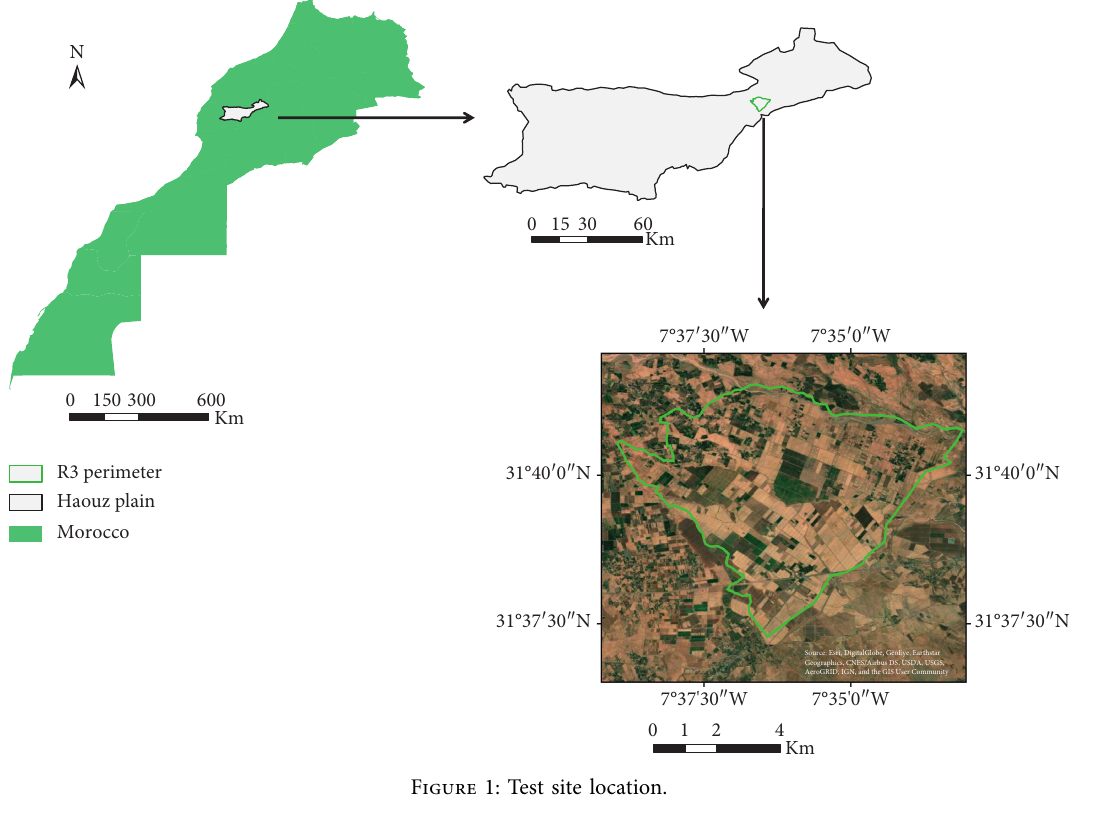
Figure 1: Test site location.